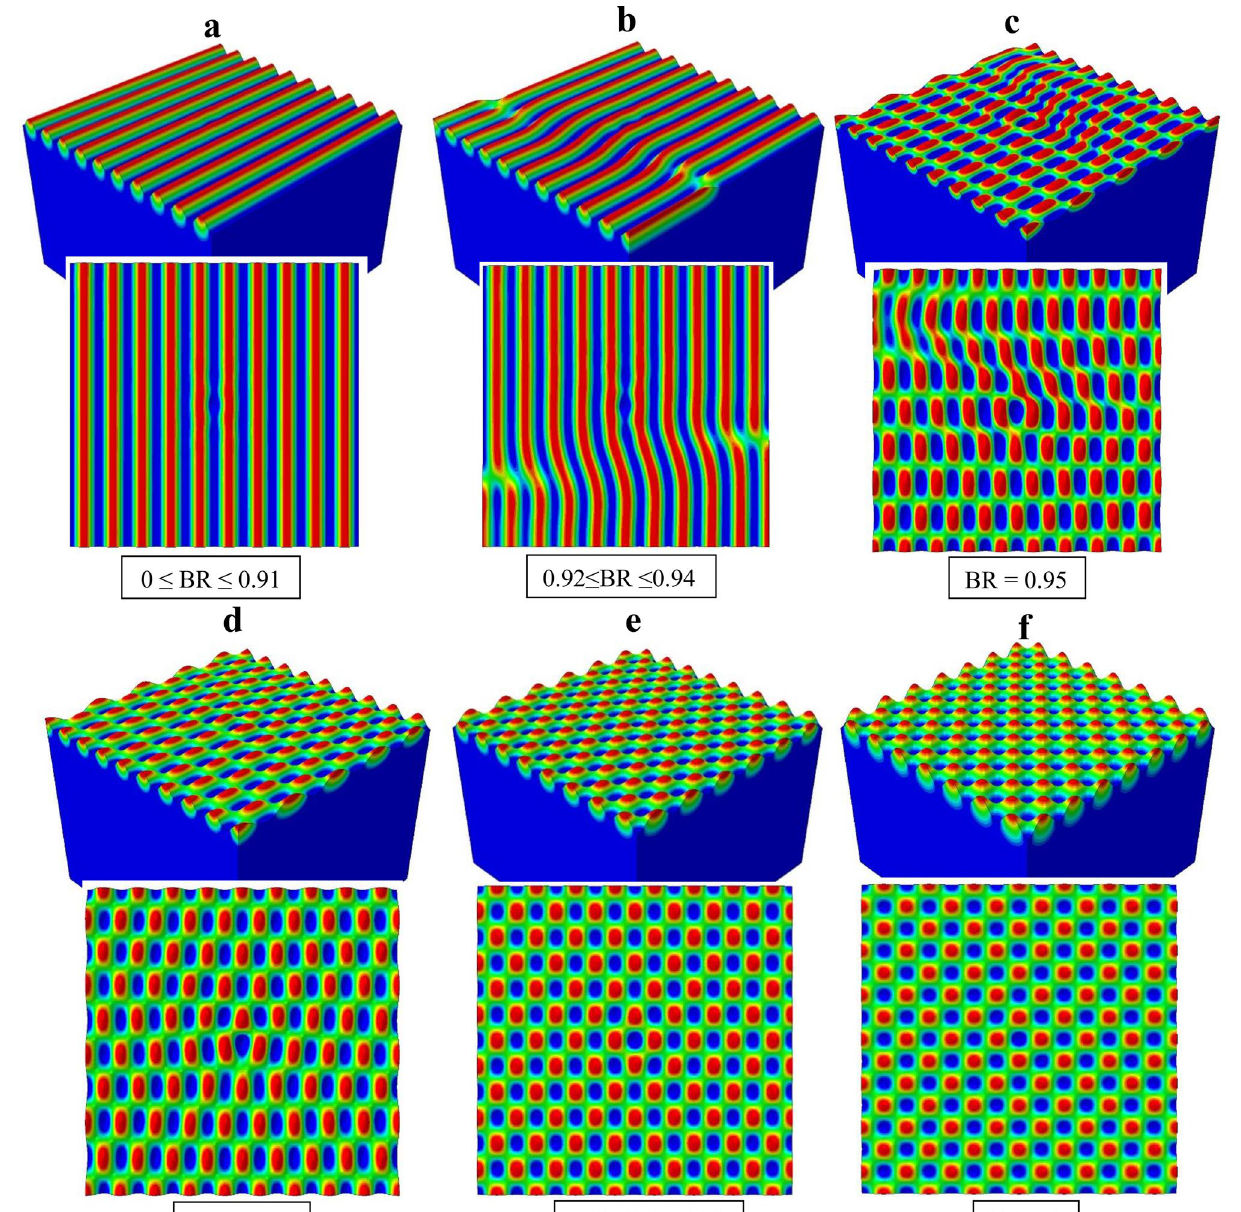
Figure 7. Primary deformation instability patterns obtained for various biaxiality